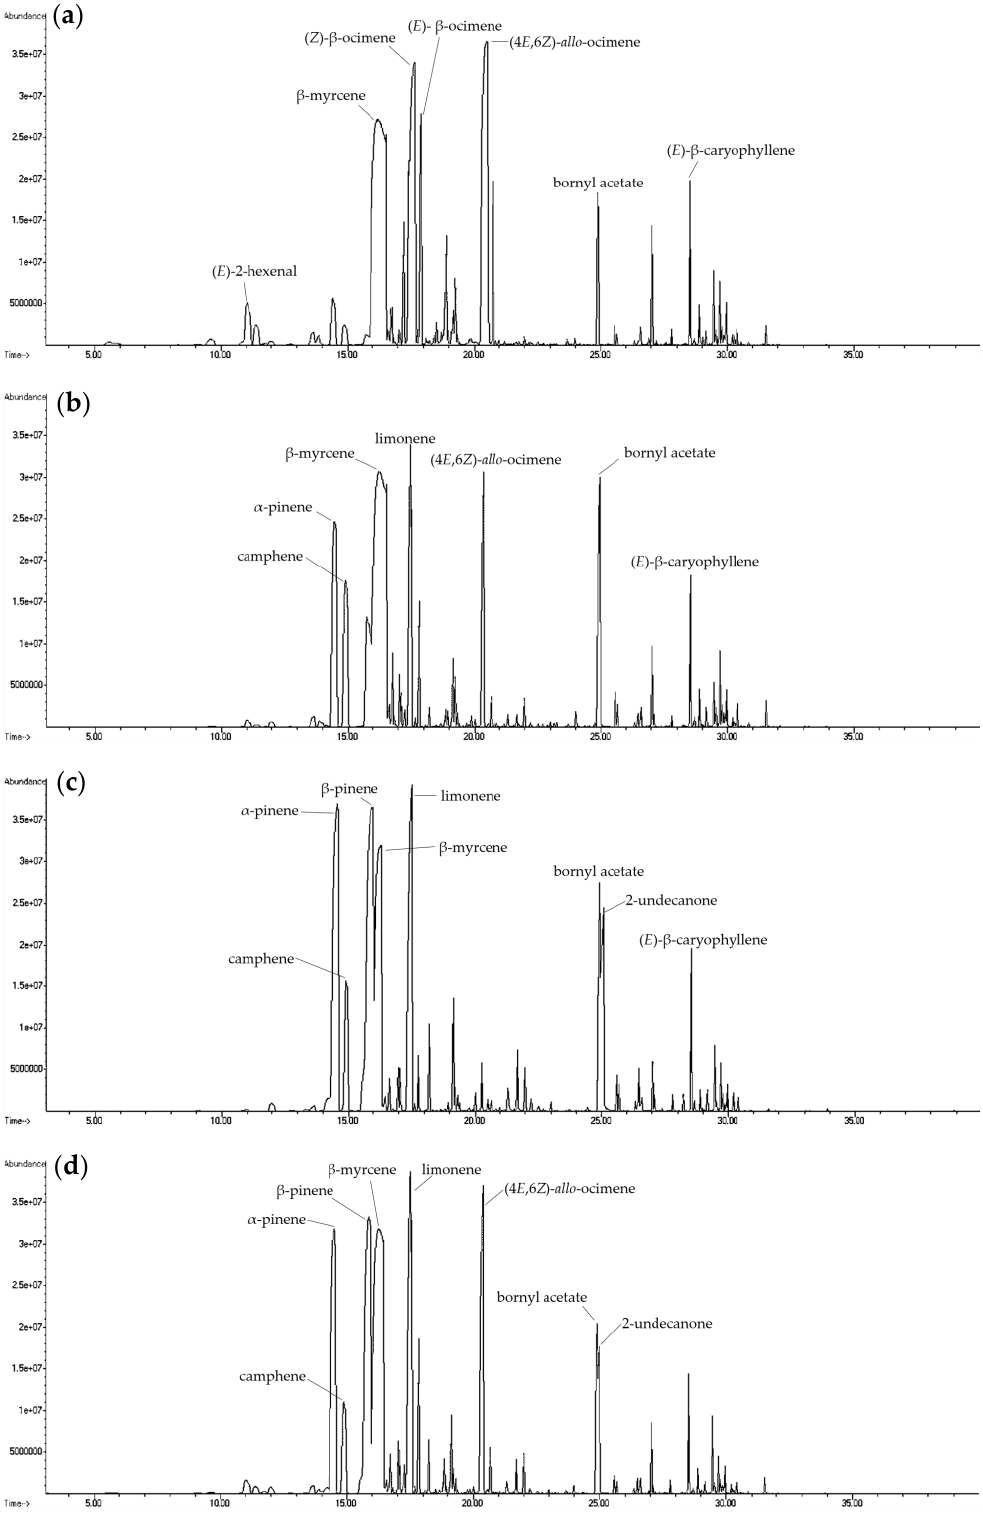
Figure 2. Ion chromatogram of volatile compounds in essential oil from different parts of fresh H. cordata analyzed by HS-SPME: ( a ) leaf; ( b ) stem; ( c ) rhizome; and ( d ) whole plant.